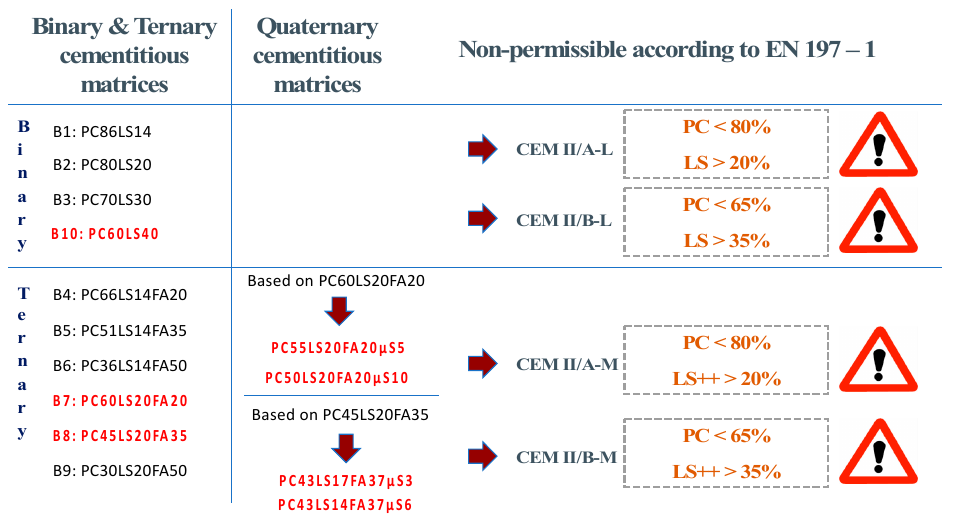
Figure 2. Binary, ternary and quaternary matrices developed for the current research compared with the limitations posed by Eurocode BS EN 197-1.